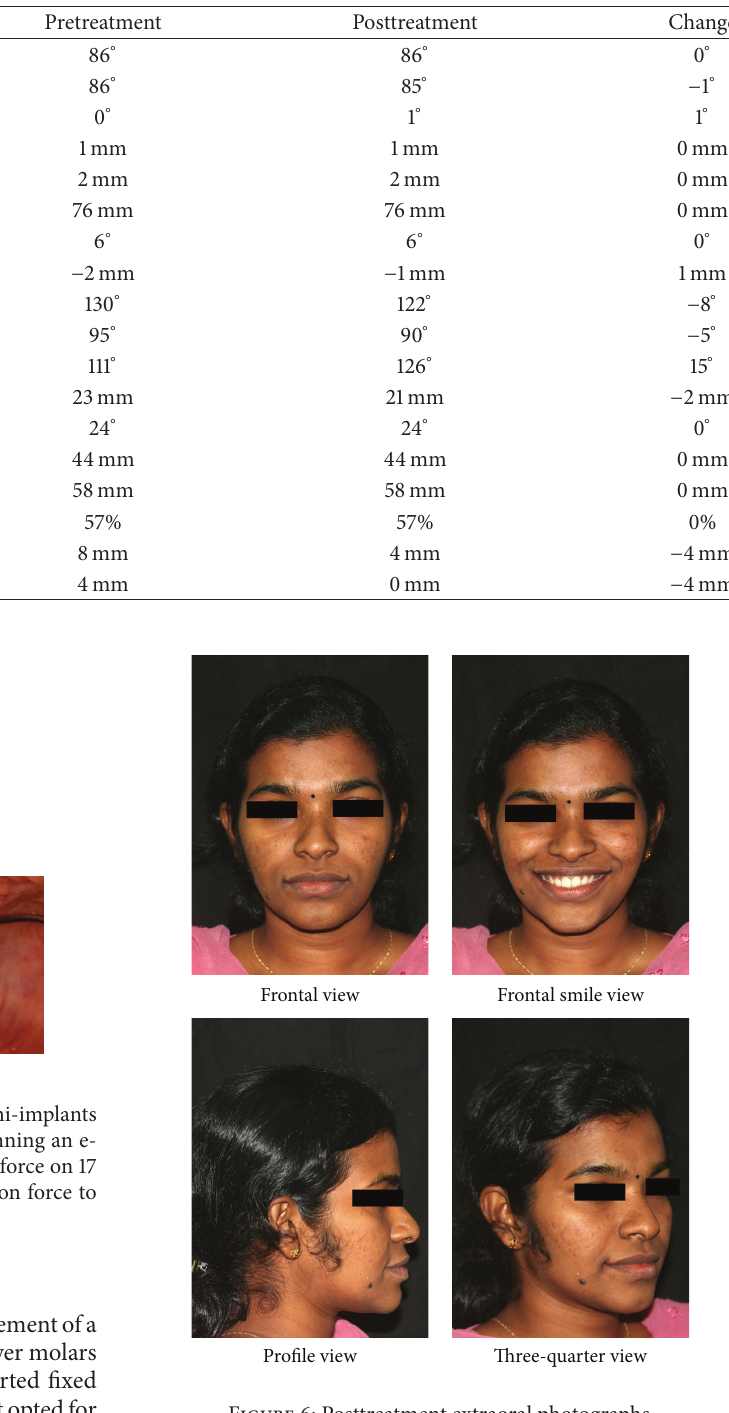
Figure 6: Posttreatment extraoral